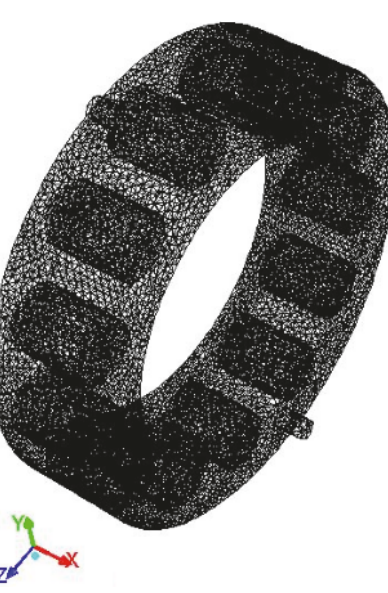
Figure 3: Meshing model of bearing cavity.